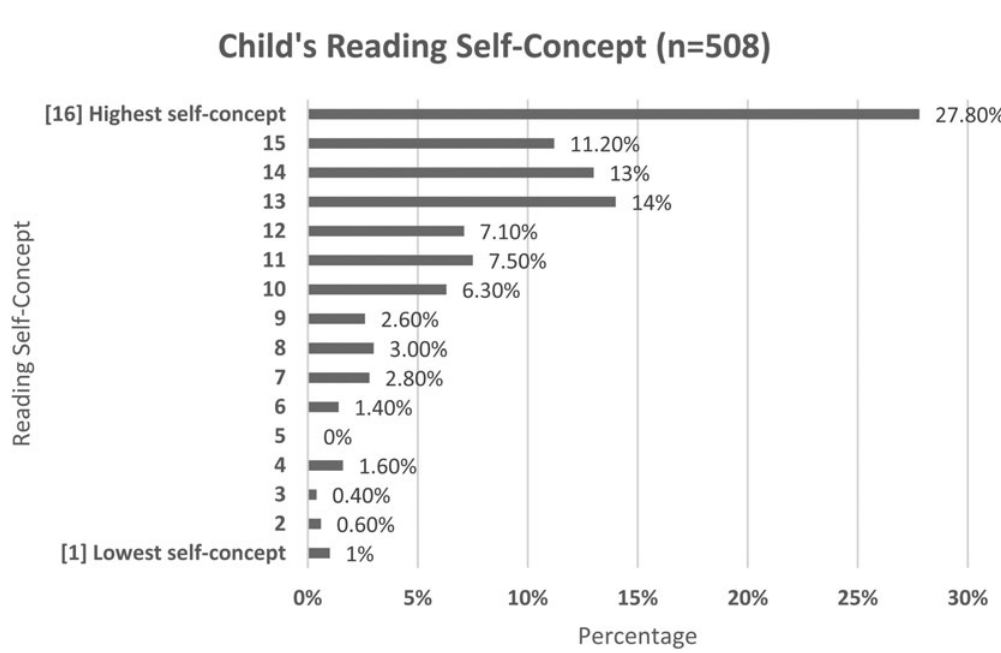
Fig. 2. Child ’ s reading self-concept ( n =508).